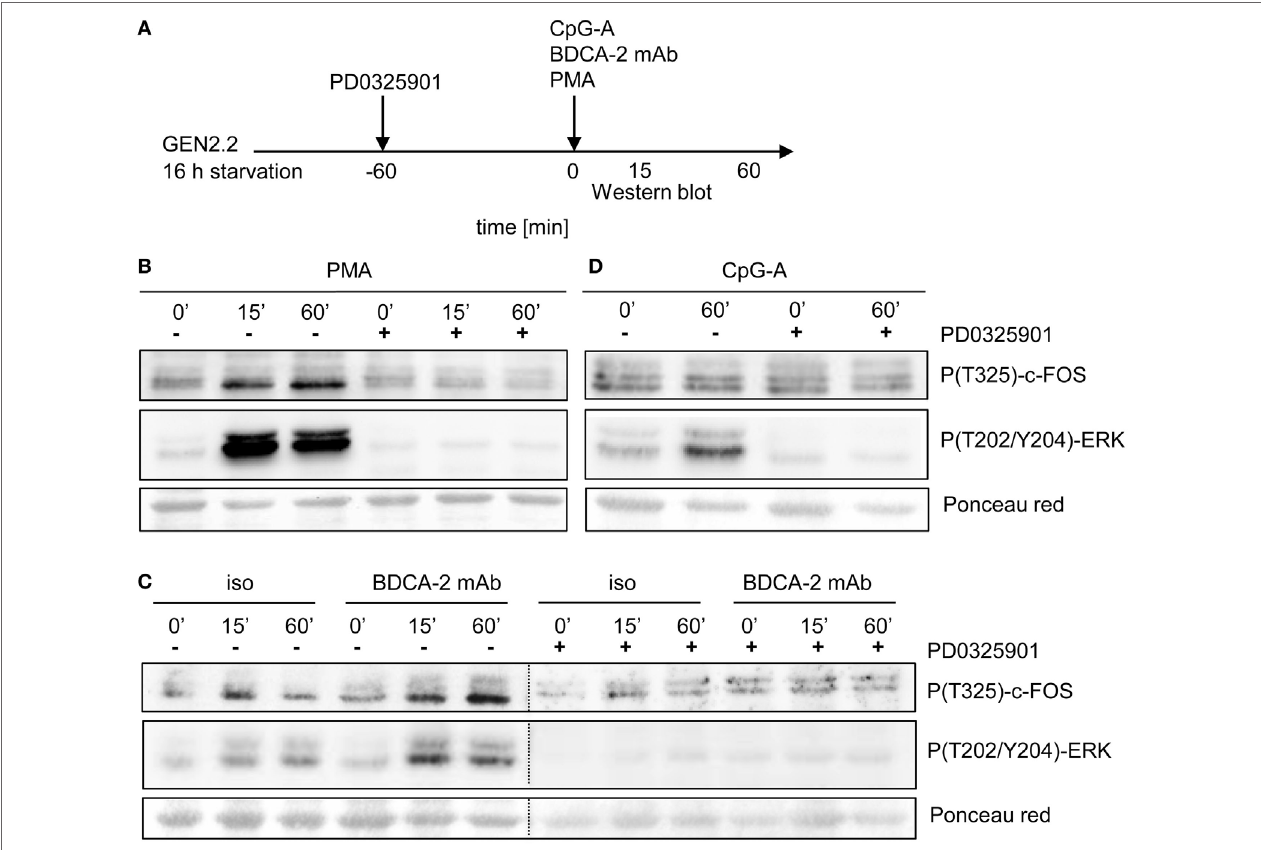
FigUre 10 | Activation of c-FOS and ERK in GEN2.2 cells stimulated with phorbol myristoyl acetate (PMA), blood dendritic cell antigen 2 (BDCA-2) mAb and CpG-A. (a) Experimental outline. GEN2.2 cells separated from MS-5 feeder cells and starved in a serum-free medium for 16 h were pretreated or not with MEK1/2 inhibitor PD0325901 for 1 h and then stimulated with PMA (B) , BDCA-2 mAb (c) , or CpG-A (D) . The activation of c-FOS was evaluated by analysis of c-FOS phosphorylation using Western blotting with the P(T325)-c-FOS antibody. The phosphorylation of ERK-1 was determined by P(T202/Y204) ERK-1. Ponceau red was used as a loading control. Figure (c) is composed of two images of two different gels with samples from the same experiment. The two images are separated by a dotted line. Full scans of the original gels are shown in Figure S7 in Supplementary